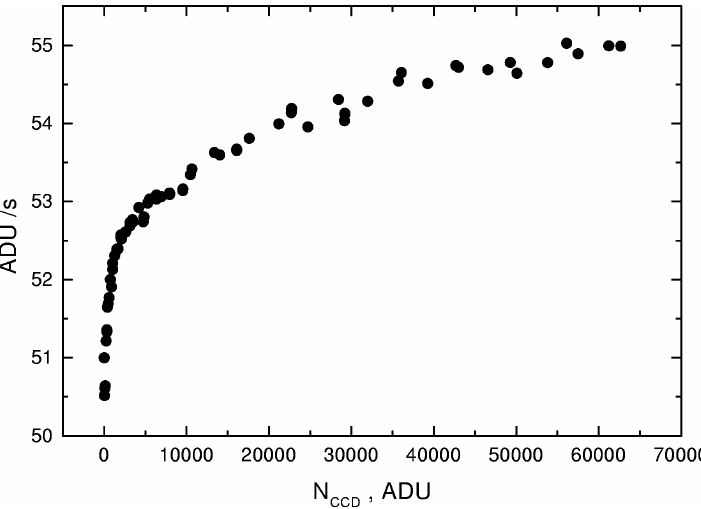
Fig. 2. Dependence of the number of counts (ADU) per second n on the total number of the registered counts N